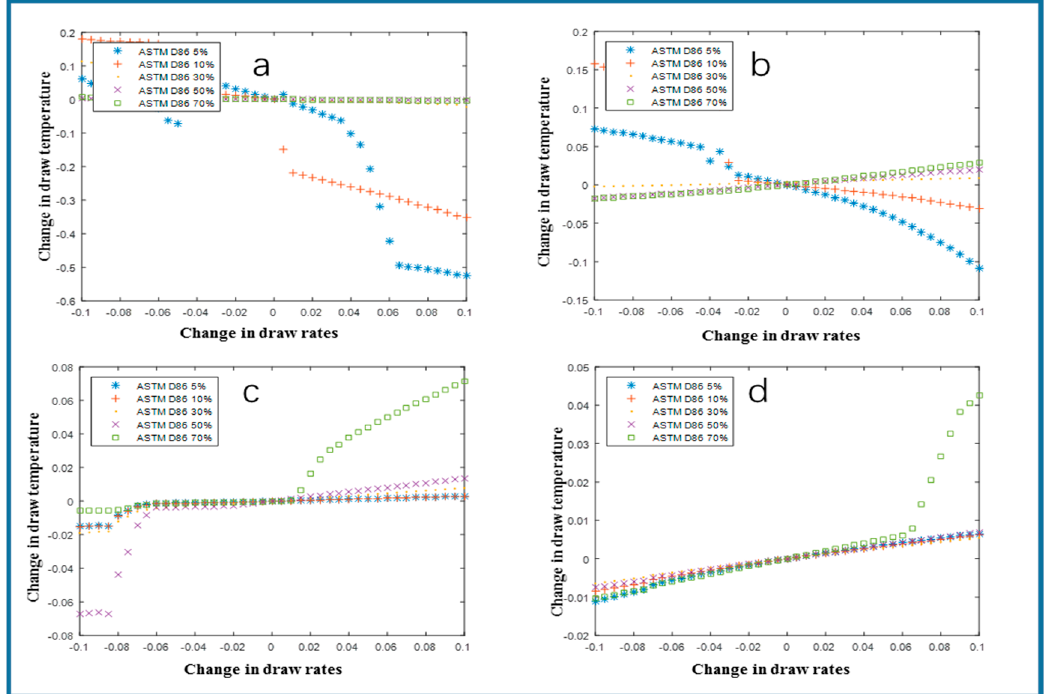
Figure 11. Sensitivity results of the side draw rate and temperature change of different products and methods: ( a ) naphtha with the HCRSRK method; ( b ) naphtha with the data-based delumping method; ( c ) diesel with the HCRSRK method; ( d ) diesel with the data-based delumping method.